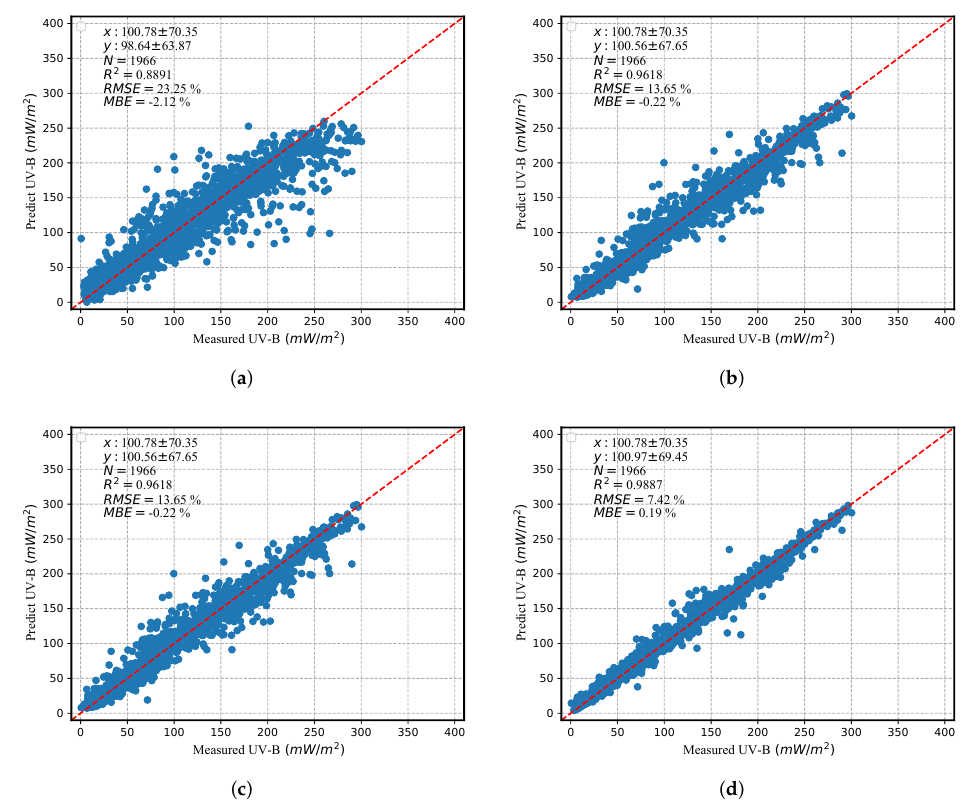
Figure 6. Comparison between measured erythemal UV-B and estimated erythemal UV-B on SURFRAD test data: ( a ) SVR model; ( b ) RF model; ( c ) DRFCN+SVR model; ( d ) DRFCN+RF